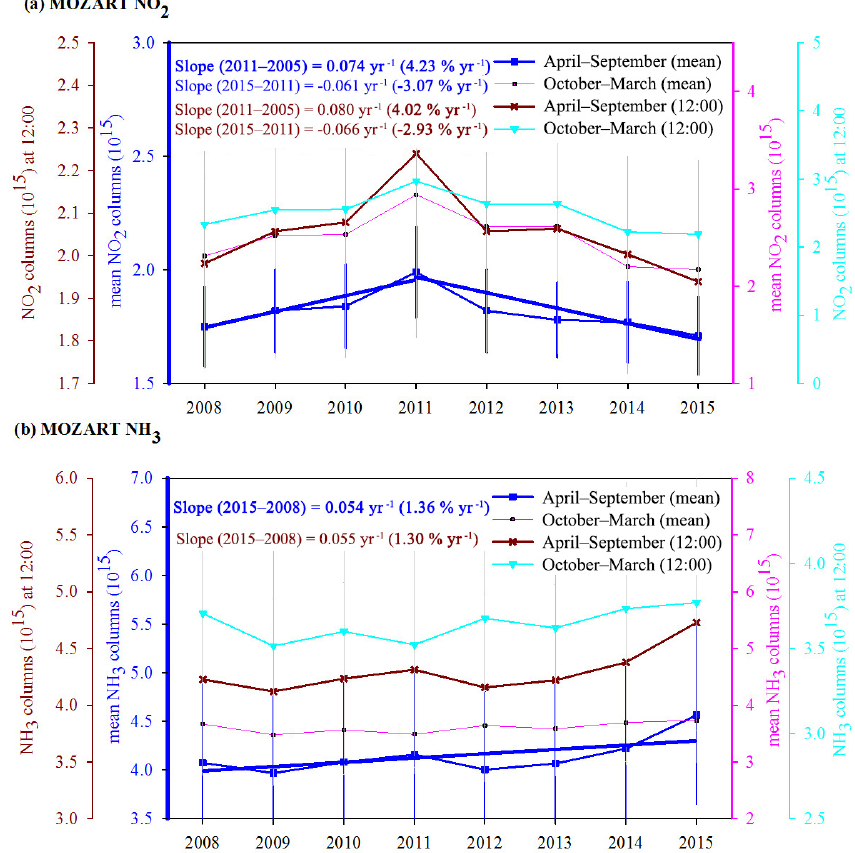
Figure 5. Time series of MOZART NO 2 and NH 3 columns over China during average warm months (April–September) and cold months (October–March) from 2008 to 2015. The mean columns were calculated by averaging the columns at 00:00, 06:00, 12:00 and 18:00. The associated mean error for each period is presented here as error